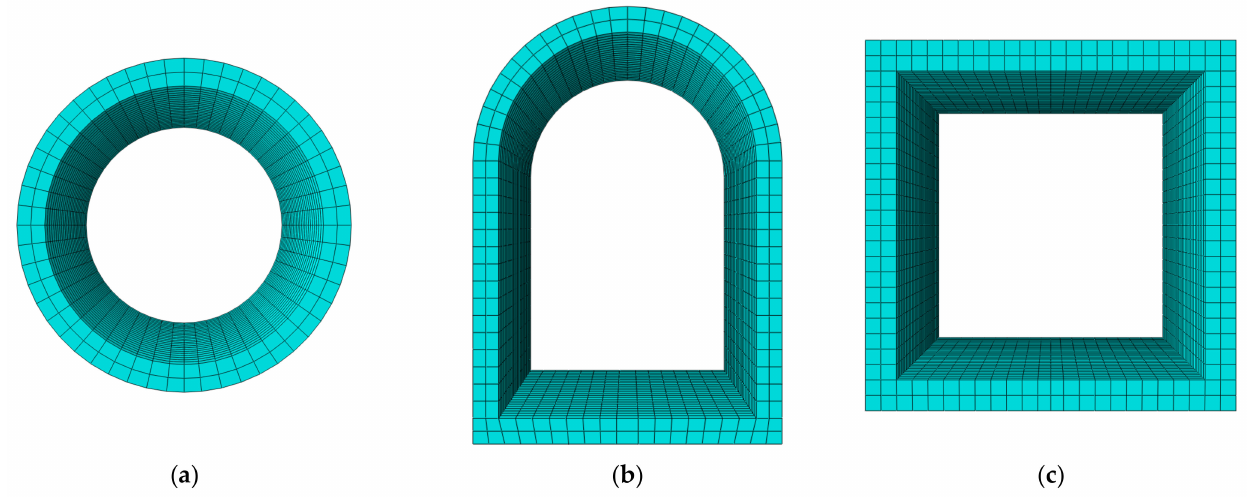
Figure 7. Meshed FEM models of ( a ) circular, ( b ) rectangular and ( c ) arched